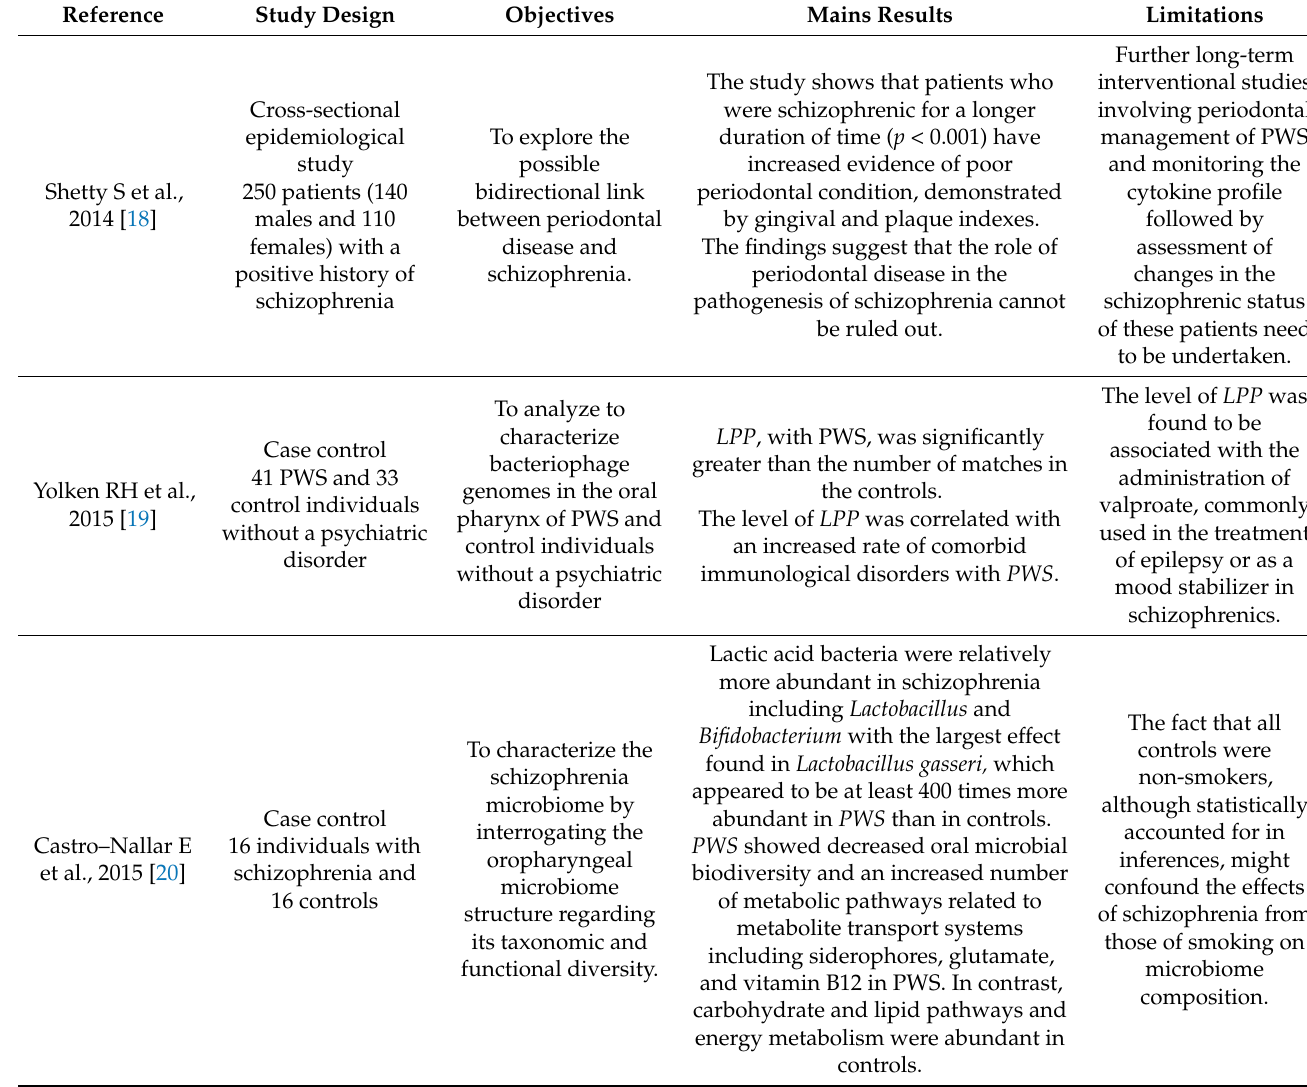
Table 1. Analysis of selected